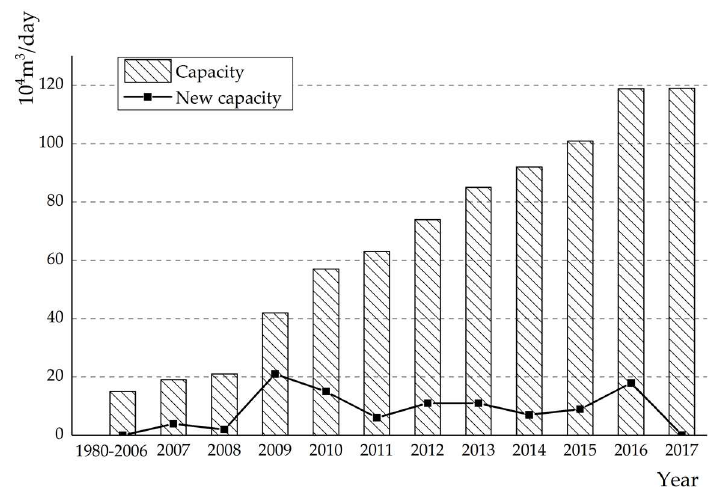
Figure 3. The construction of Chinese desalination projects from 1980 to 2017. Data Source: Desalination Branch of China Water Enterprises Confederation, “China Desalination Yearbook 2016–2017” [24]. The data by the end of 2015 was also presented in Zhu et al.